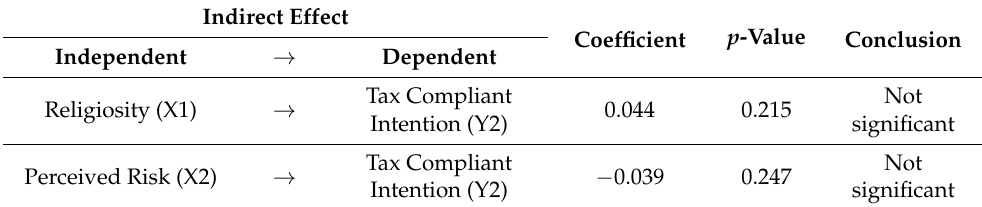
Table 5. Result of estimation and testing of indirect